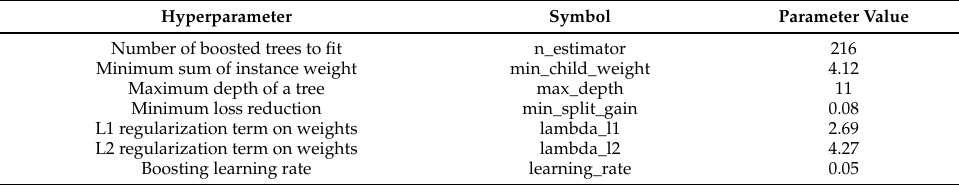
Table 5. Main hyperparameters for LightGBM